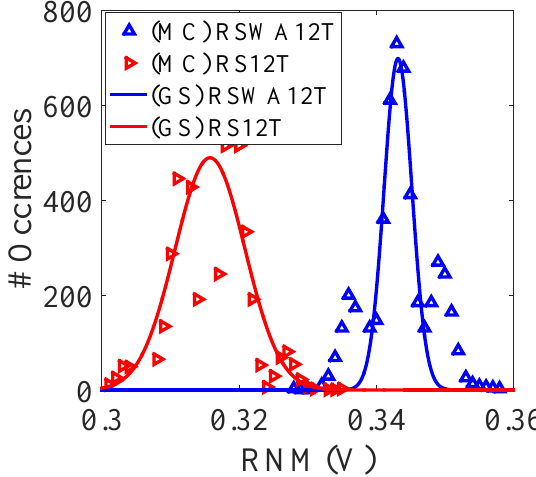
Figure 23. Process variation analysis of RNM for proposed SRAM cell.